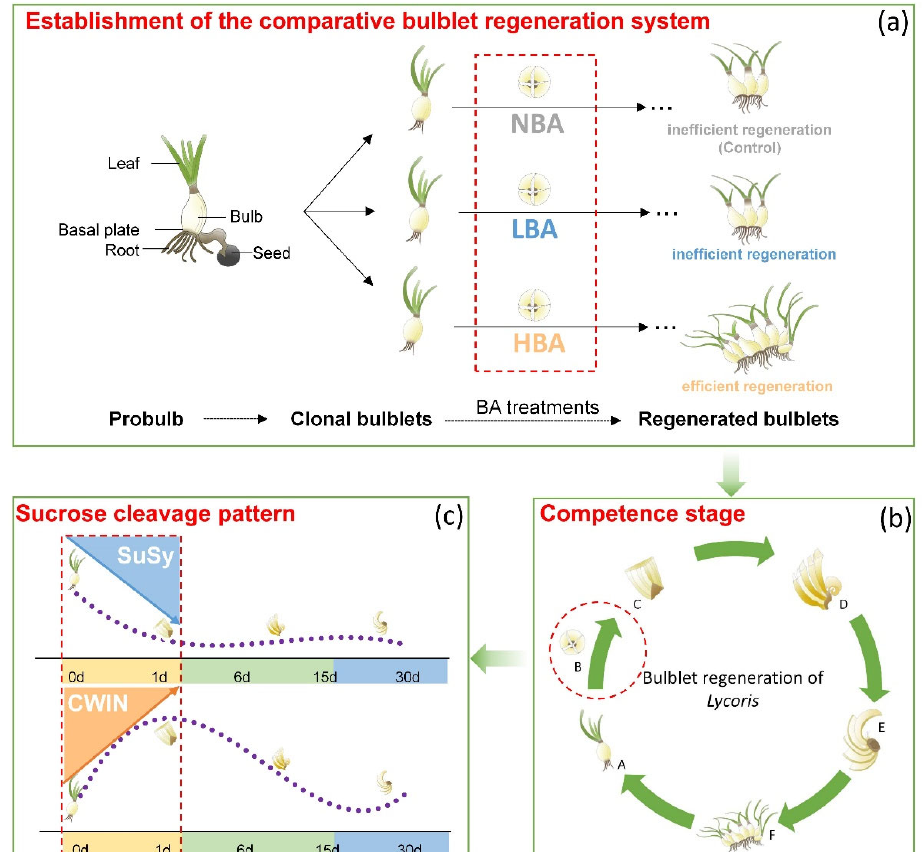
Figure 7. Model of how the early in vitro bulblet regeneration of Lycoris sprengeri is regulated from a sucrose cleavage pattern perspective. ( a ) By adjusting the BA concentration in media, we established the efficient and inefficient bulblet regeneration systems. ( b ) Horizontal comparison between groups indicated the pivotal role of the competence stage. ( c ) Bulblet regeneration is likely triggered by sucrose cleavage pattern from sucrose synthase catalyzed to invertase catalyzed at the competence stage, during which a relatively active CWIN-catalyzed sucrose cleavage pattern might lead to an increase in the number of regenerated bulblets of Ls , thus influencing bulb yield. CWIN, cell wall invertase; SuSy, sucrose synthase. The average changing patterns of LsCWIN2 and LsSuSy4 during in vitro bulblet regeneration of Ls are shown in Figure S3.